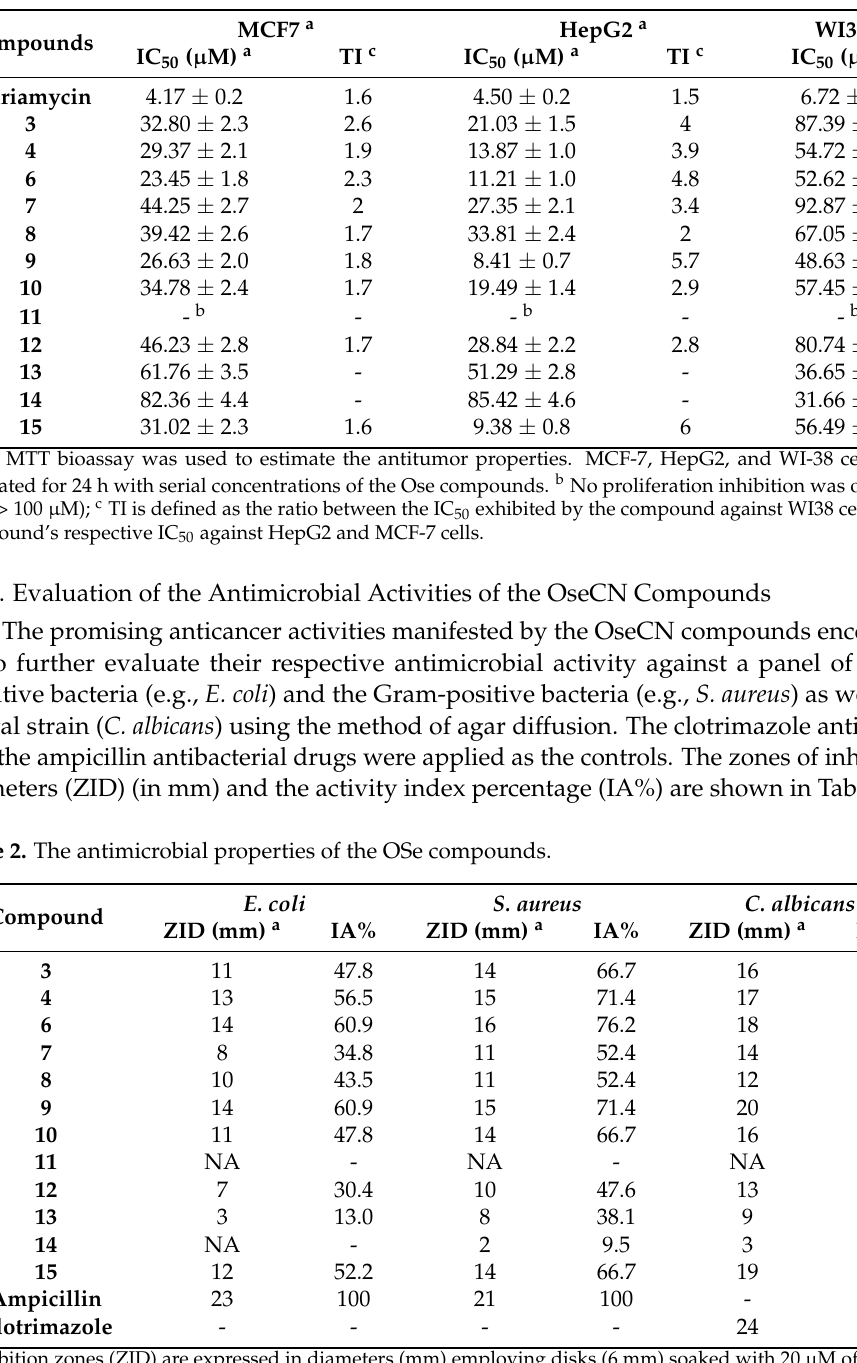
Table 1. The antiproliferative activities of the Ose compounds.